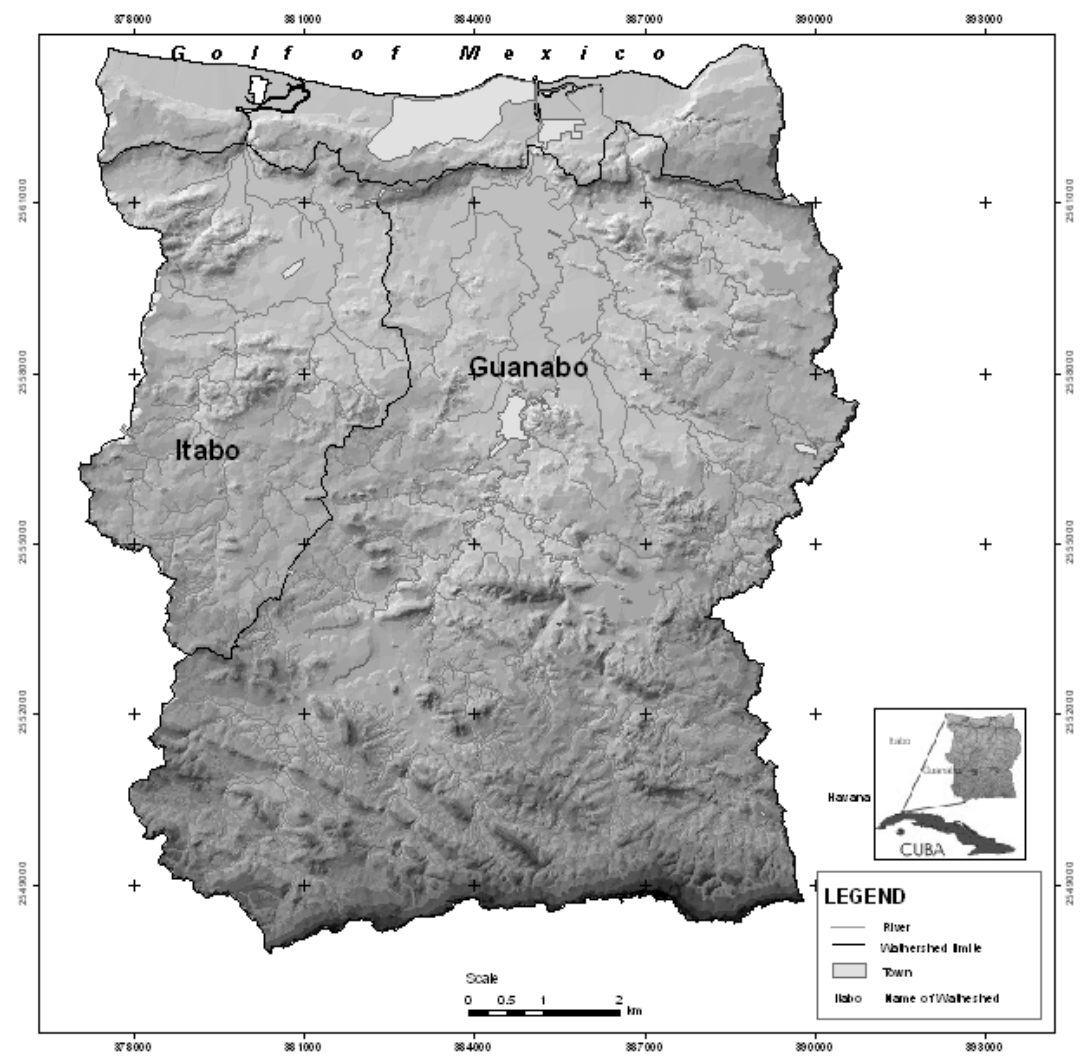
Figure 1. Location of the basins of the rivers Itabo and Guanabo in Havana,